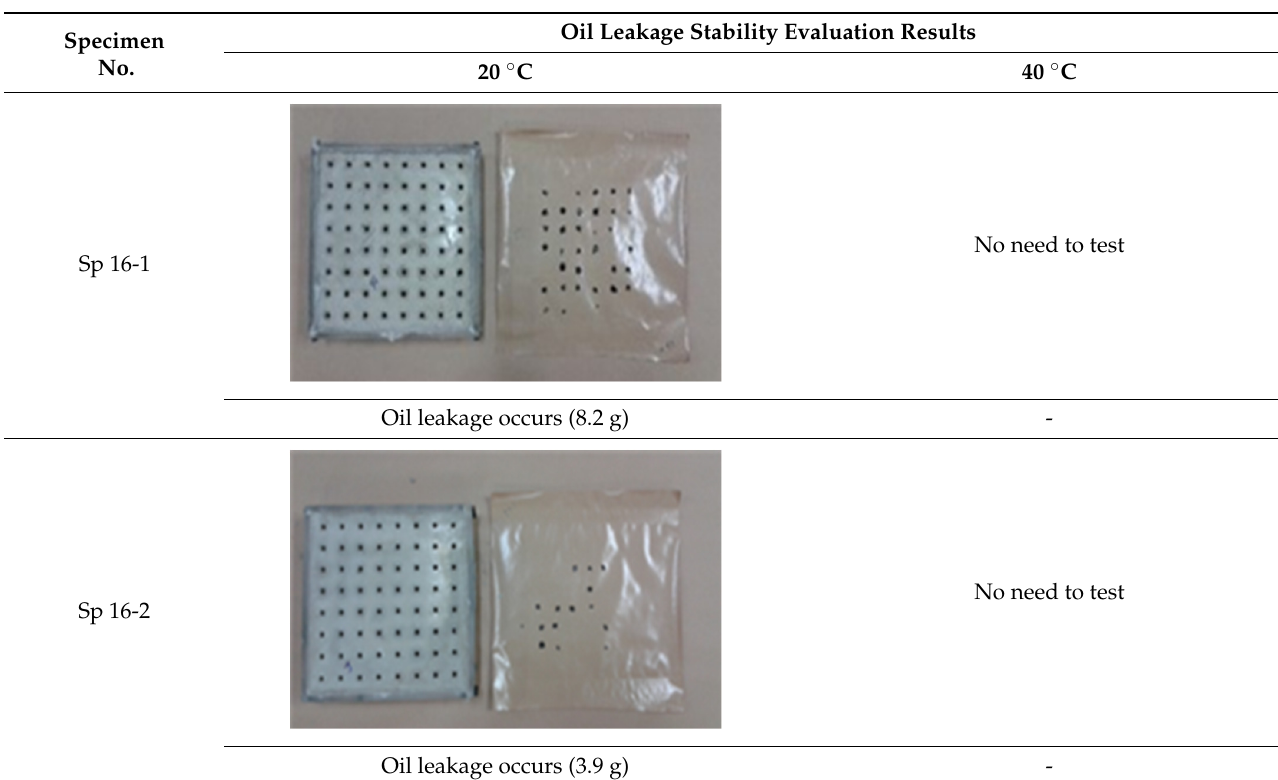
Table A1. Oil leakage stability evaluation results.